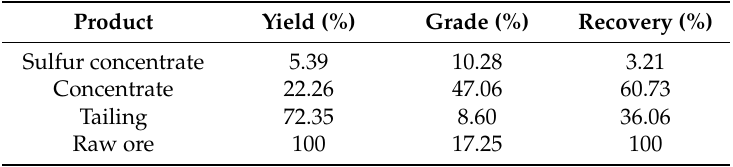
Table 9. The results of closed-circuit test of attrition-scrubbing